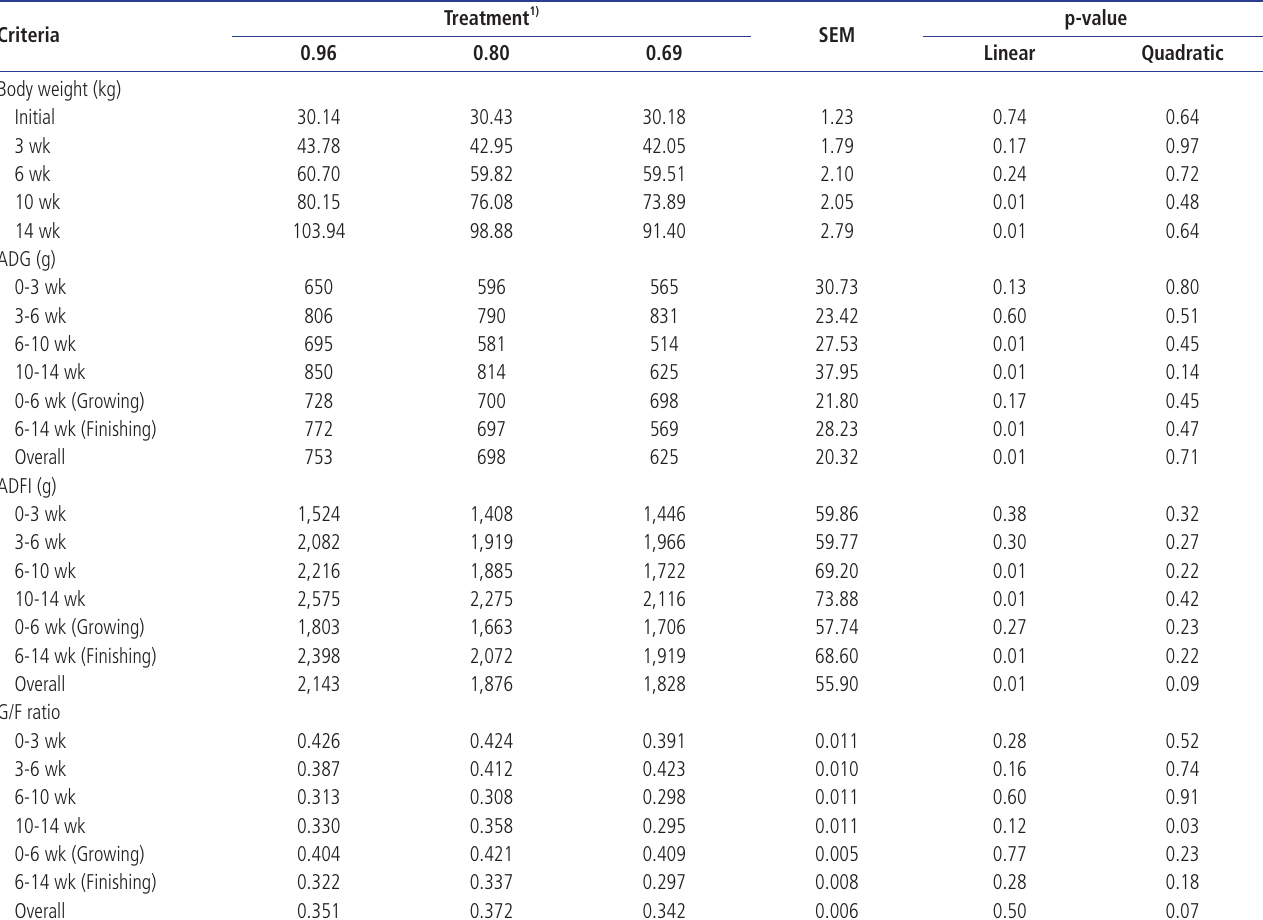
Table 2. Effect of different space allowance on growth performance in growing-finishing pigs